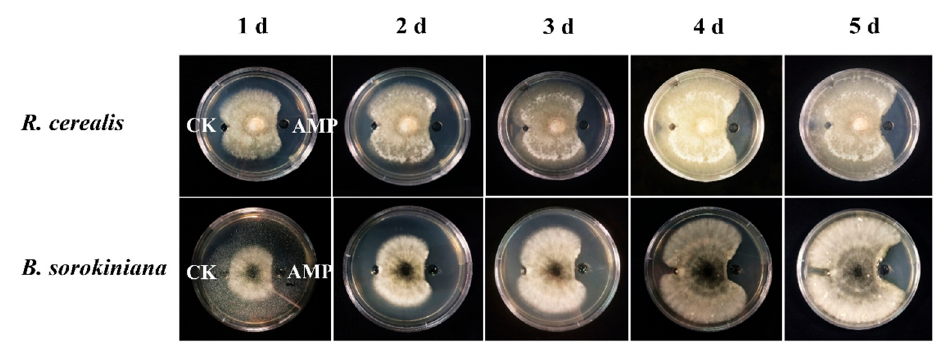
Figure 2. Inhibitory activity of DmAMP1W against Rhizoctonia cerealis and Bipolaris sorokiniana. The growth of pathogenic fungi mycelium within five days after inoculation was exhibited from left to right. The fungal mycelia on plates were treated by 65 μ g/mL MBP and 65 μ g/mL MBP-DmAMP1W, respectively. CK and AMP on the mediums represent MBP and MBP-DmAMP1W treatments, respectively. These assays were conducted three times with similar results.